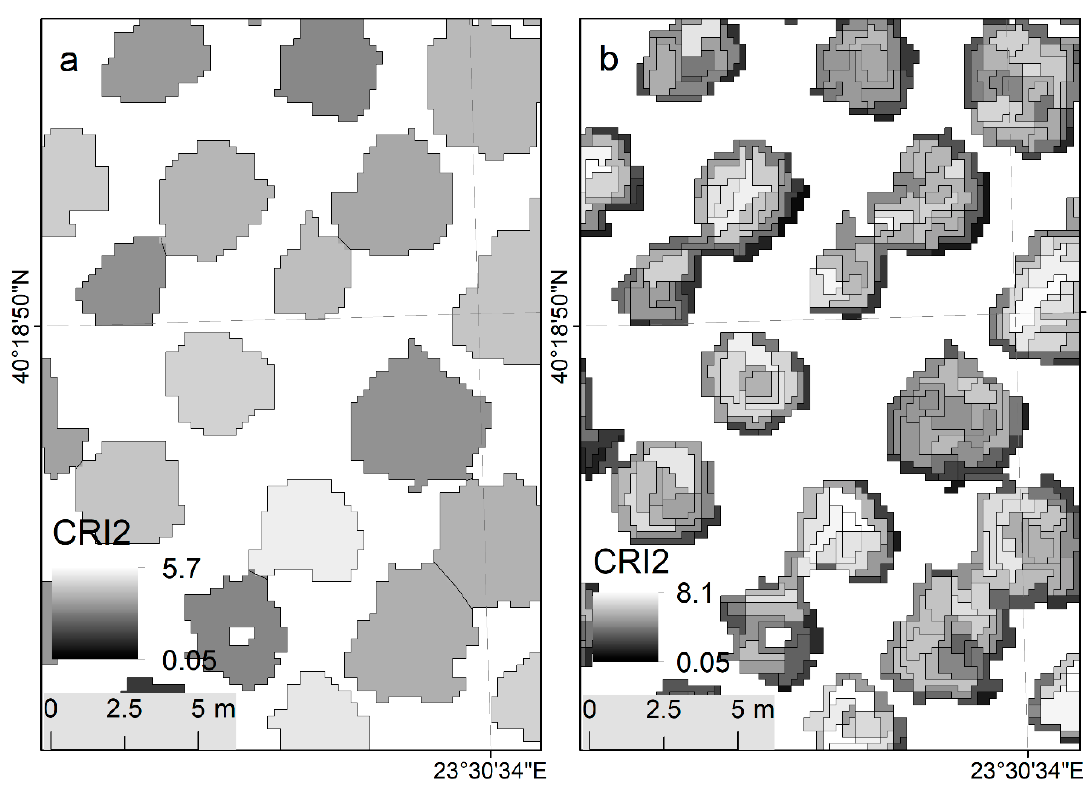
Figure 5. The CRI2 index mapped: ( a ) per tree crown (mean = 2.2, std. = 0.321, max = 5.77); ( b ) per sub-tree object (mean = 2.2, std. = 0.513, max = 8.10).